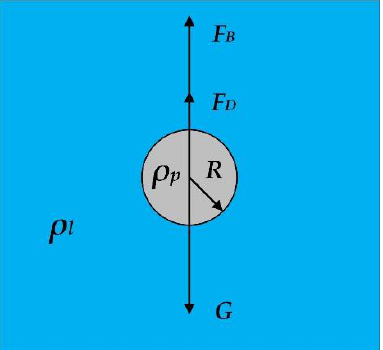
Figure 8. Schematic of the forces acting on the particle.